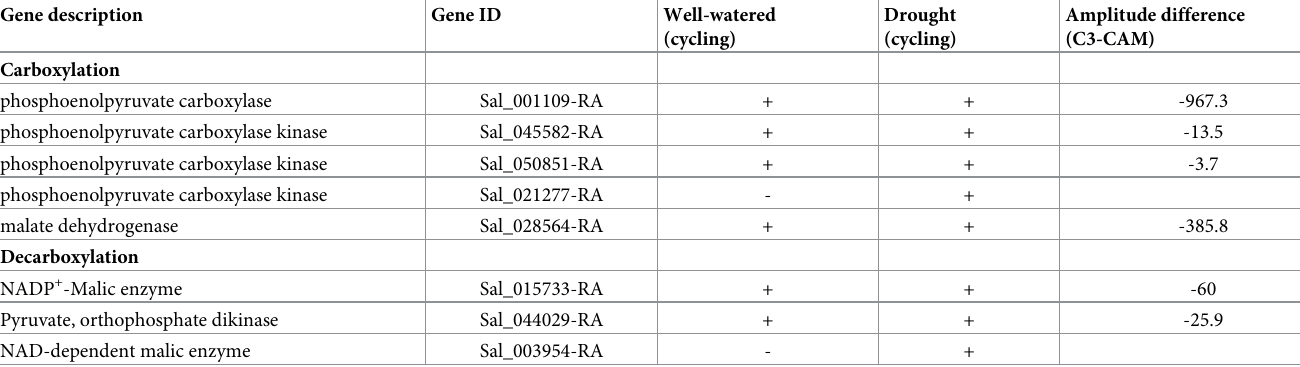
Table 2. Circadian pattern and amplitude changes of CAM photosynthesis genes between well-watered and drought S . album .